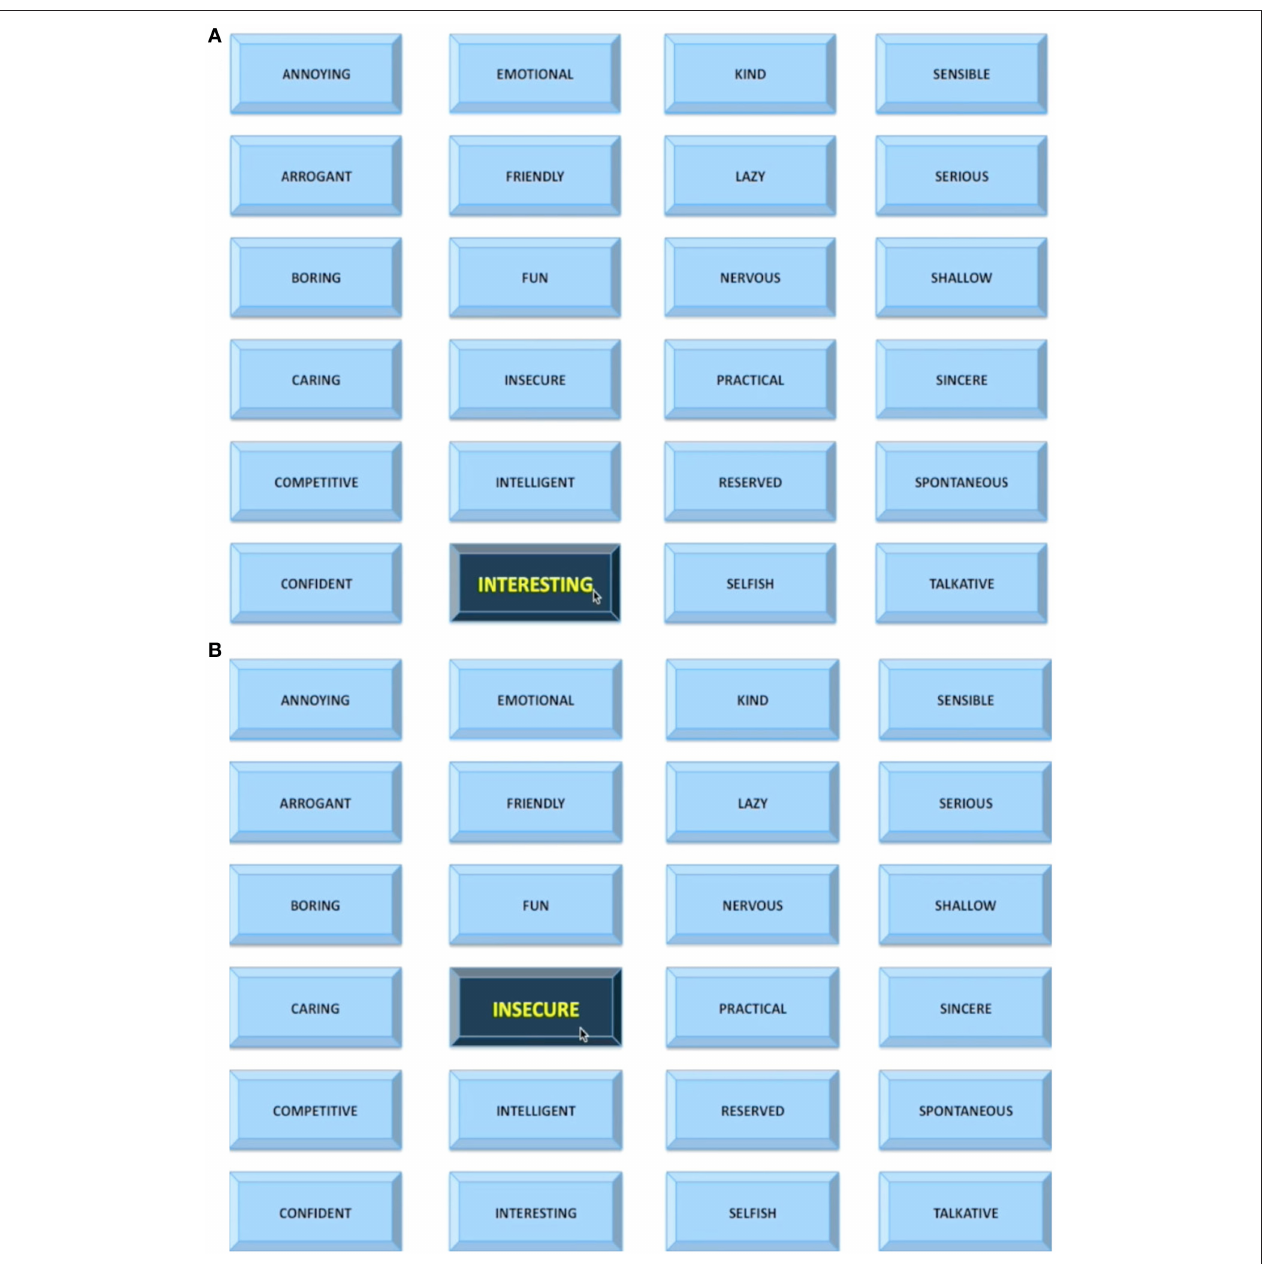
FIGURE 1 | The “impressions user interface” used in the social evaluative session. Every 10s, a participant saw a mouse click over an adjective button indicating the evaluator’s rating of the participant’s performance in the impressions interview video. The rating could be (A) positive, (B) negative, or neutral (not shown).